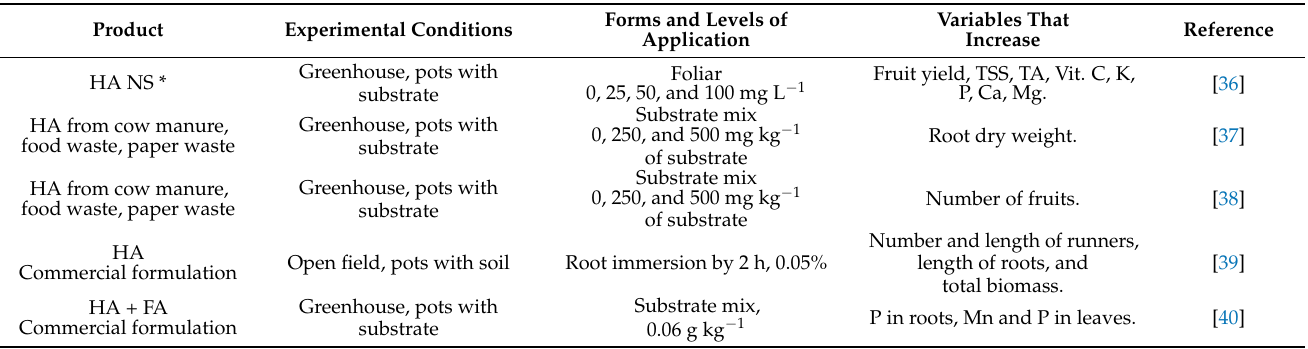
Table 1. Positive effects of HS on some growth or quality variables of strawberry